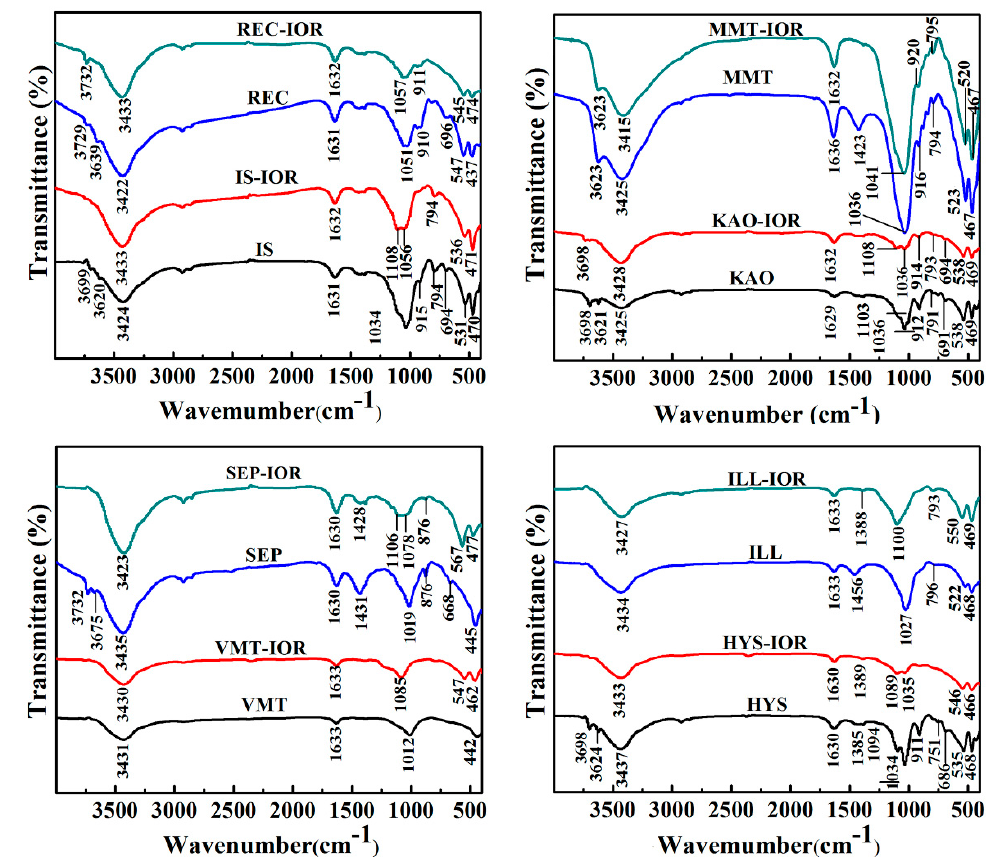
Figure 2. FTIR spectra of selected the natural clay minerals and the corresponding hybrid pigments.